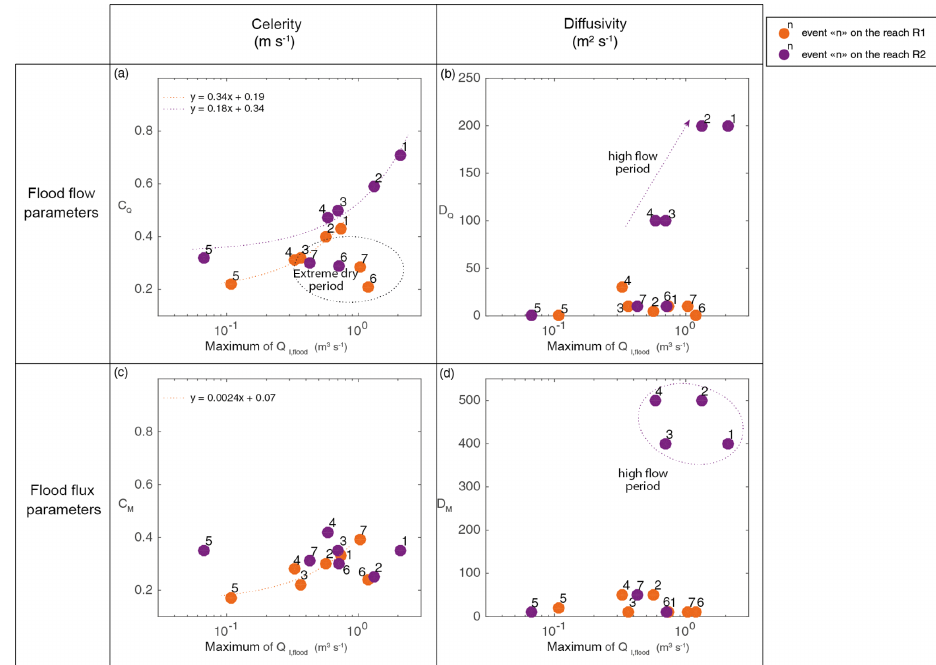
Figure 8. Parametrization analysis of the selected event set. Orange and purple symbols correspond to R1 and R2, respectively. Each parameter of the model is compared with the maximum intensity of the flood flow input signal (logarithmic scale).